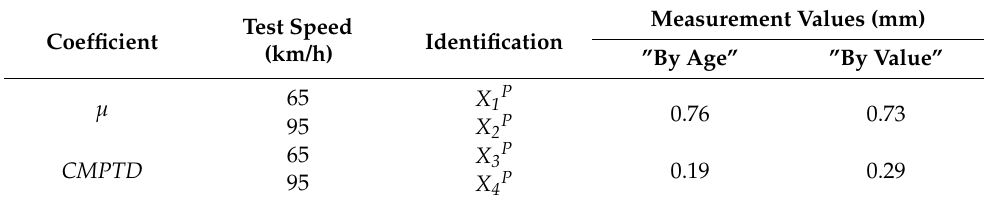
Table 9. Field tests results for cement concrete—model II (two speeds together—65 and 95 km/h in one collection).